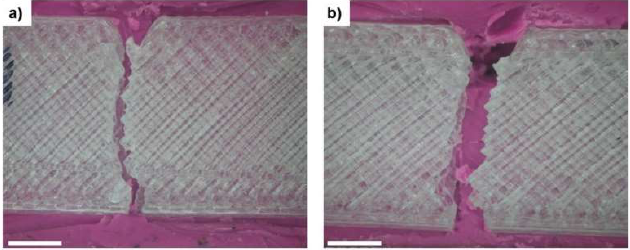
Figure 5. Damage induced by the transverse impact tests on PMMA specimens: ( a ) as printed and ( b ) aged. Scale bar: 500 µm.